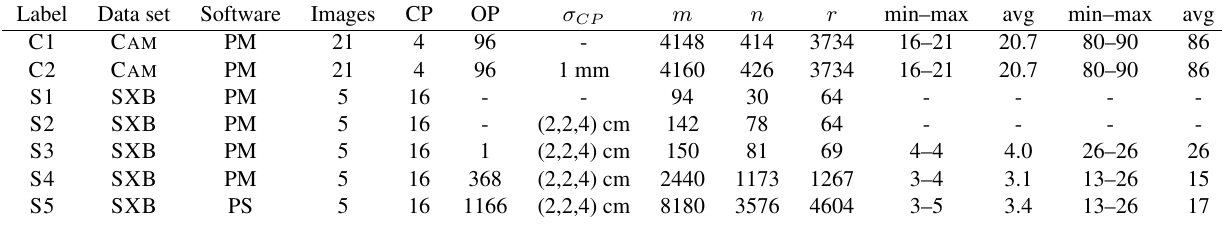
Table 1. Experiment details. The number of control points (CP) and object points (OP) are given together with the a priori standard deviation σ CP for the control points. Furthermore, the total number of observations m and unknowns n used to compute the redundancy r is given. Ray counts and ray angle statistics for the OPs are also given.